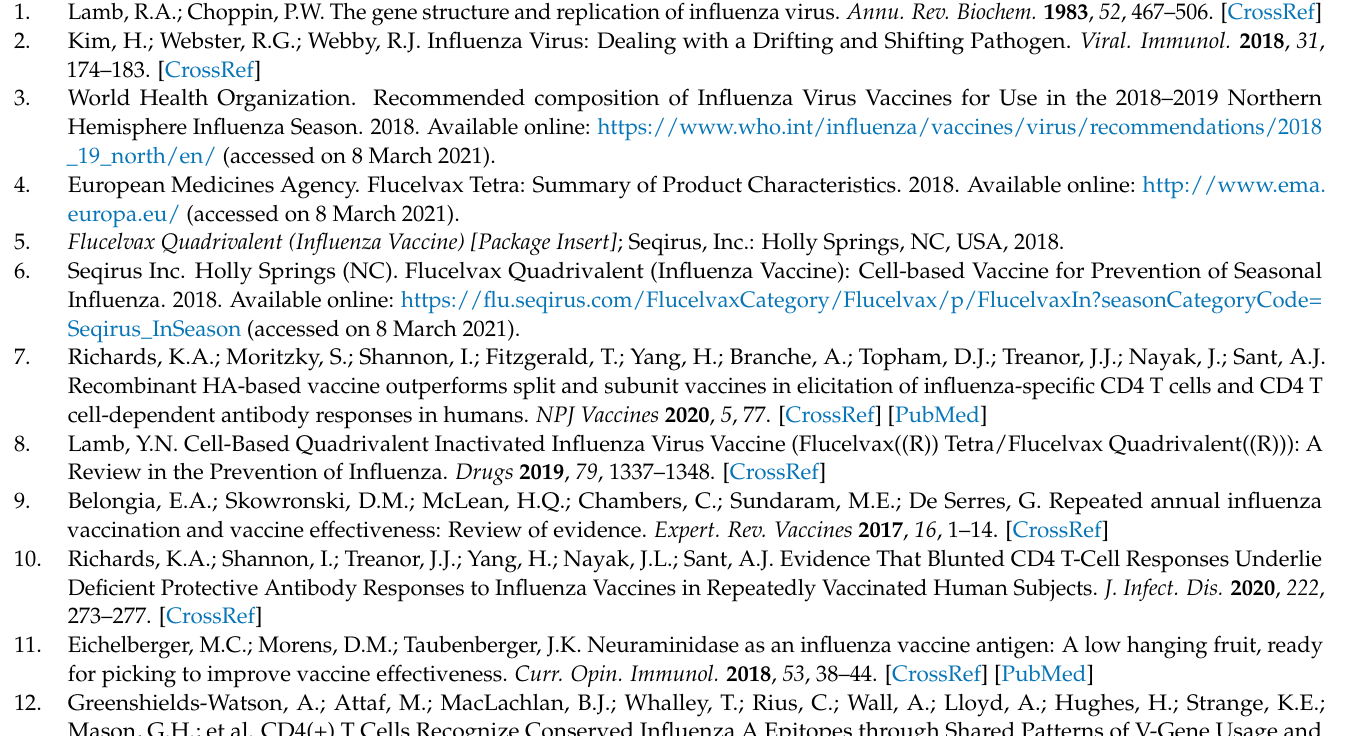
List of antibodies used in the intracellular cytokine staining (ICS) assay, Table S6: Sequence similarity analysis of viral protein MPs: calculated as number (and percentage) of common peptides shared between four different